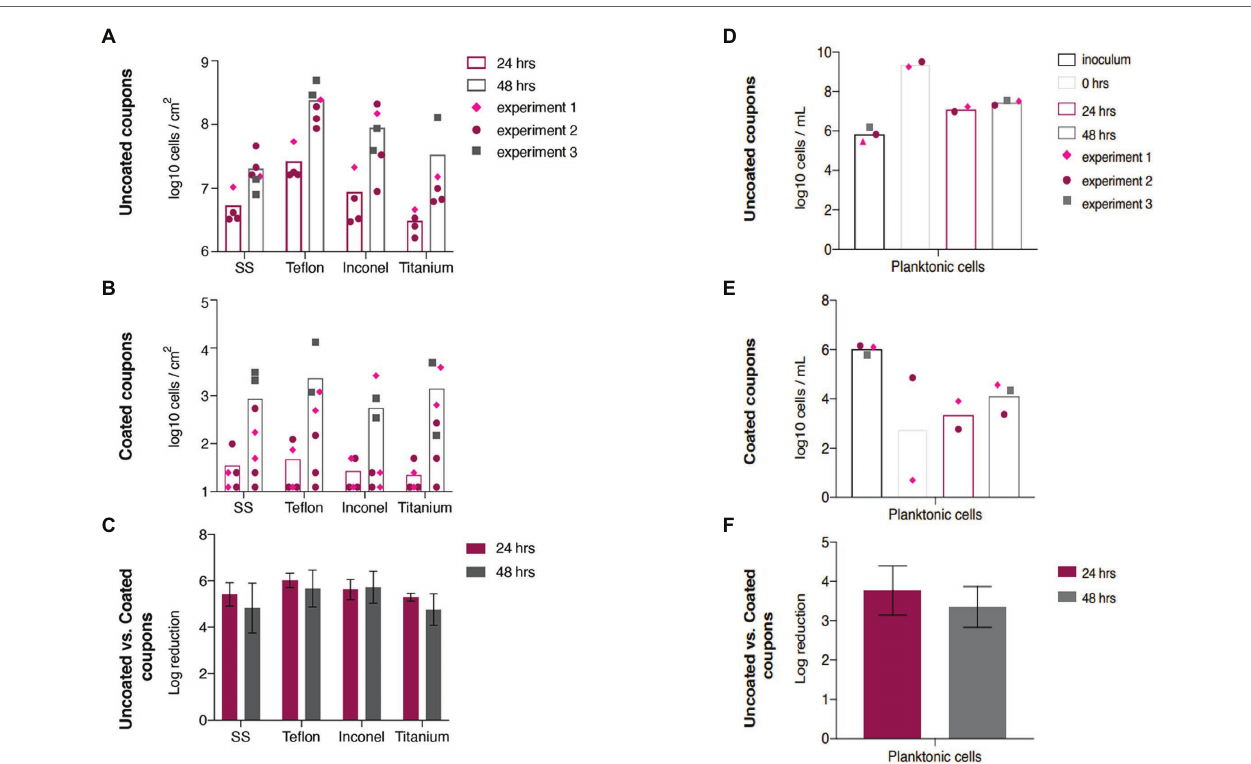
FIGURE 2 | Tryptic soy broth (TSB)-grown Pseudomonas aeruginosa biofilm accumulation and planktonic cell density. TSB-grown P. aeruginosa biofilm cell densities at 24 and 48 h after start of continuous flow on (A) uncoated and (B) coated materials. (C) Log reduction of TSB-grown biofilm accumulation on materials at 24 and 48 h. Inoculum and planktonic cell densities at 0, 24, and 48 h after start of continuous flow for reactors with (D) uncoated and (E) coated materials. (F) Log reduction of planktonic cells at 24 and 48 h. Error bars represent 95%